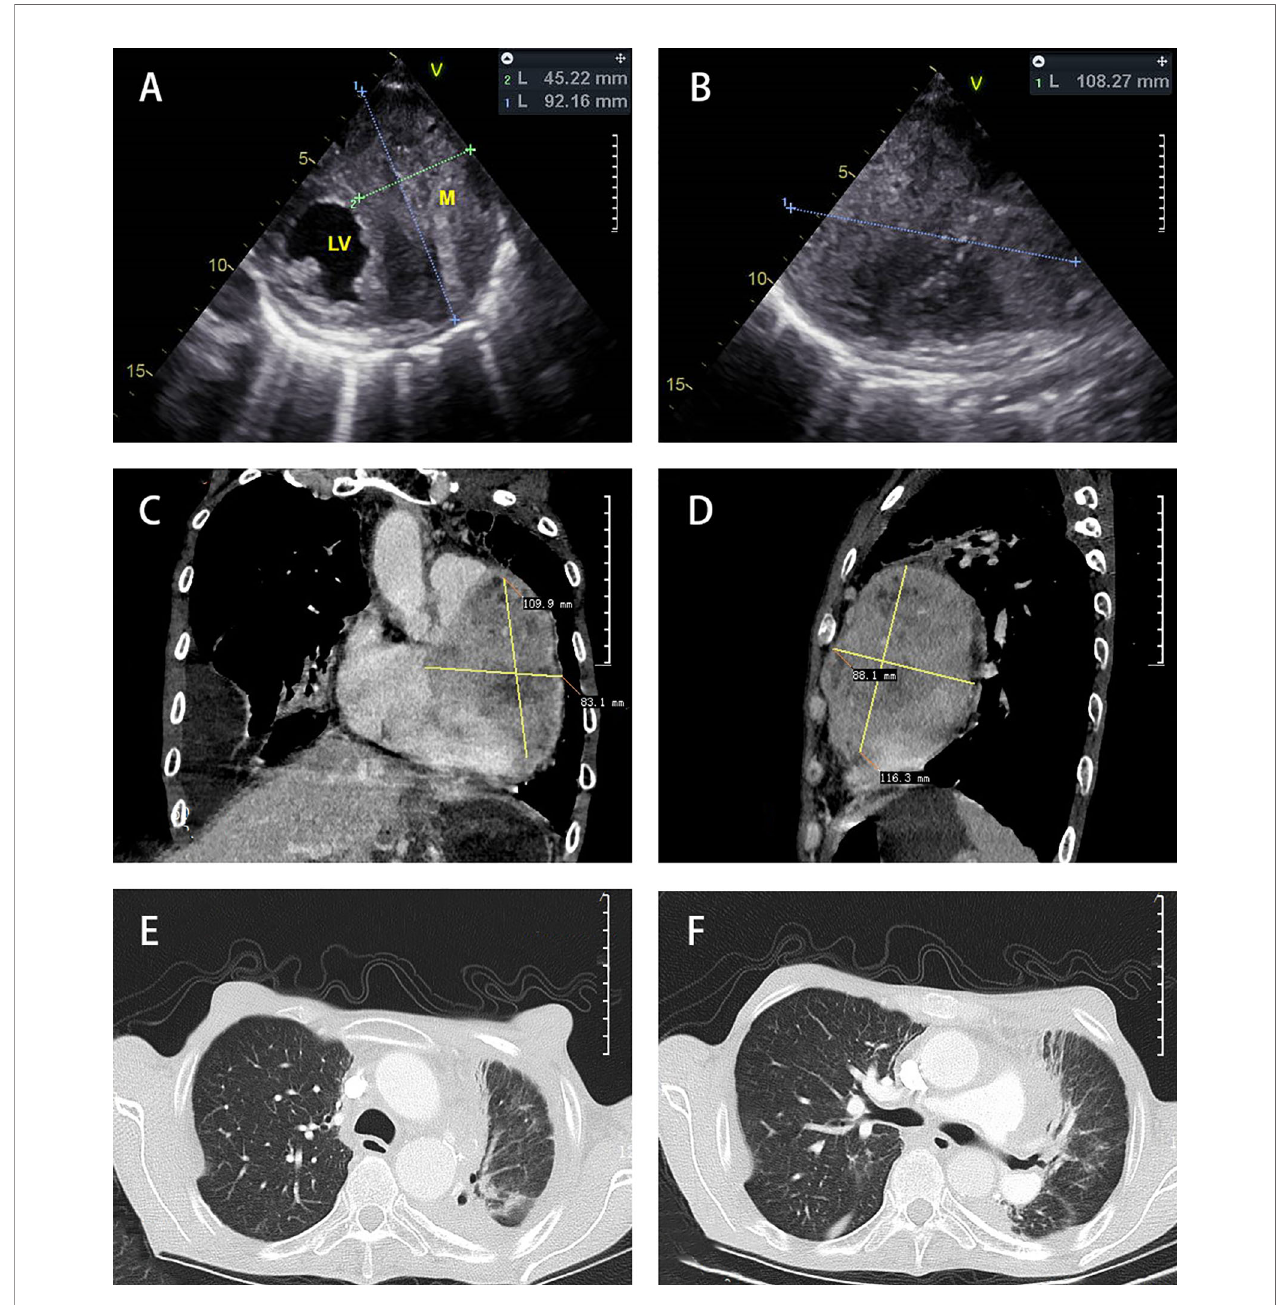
FIGURE 1 | Diagnostic imaging. Echocardiography (A, B) showed a hypoechoic mass in the left ventricle and the anterolateral right ventricle. Chest CT scan mediastinal window (C, D) with contrast enhancement showed that the heart shadow had increased. A round, soft-tissue mass was observed at the left edge of the Cardiac margin. Multiple lymph node shadows were observed at the left hilum of the lung and mediastinum. The chest CT scan lung window (E, F) showed right pleural effusion and bilateral